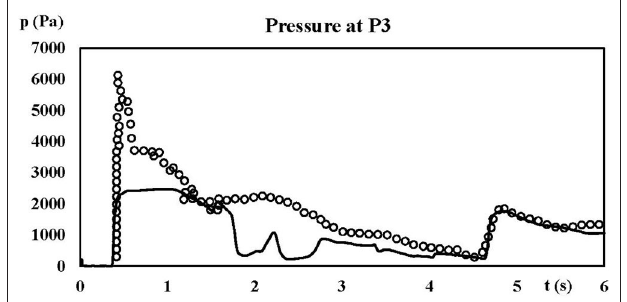
FIGURE 3 | Test case I. Time history of the pressure at probe P 3 . Solid line: DBE numerical results. Dots: Experimental results.